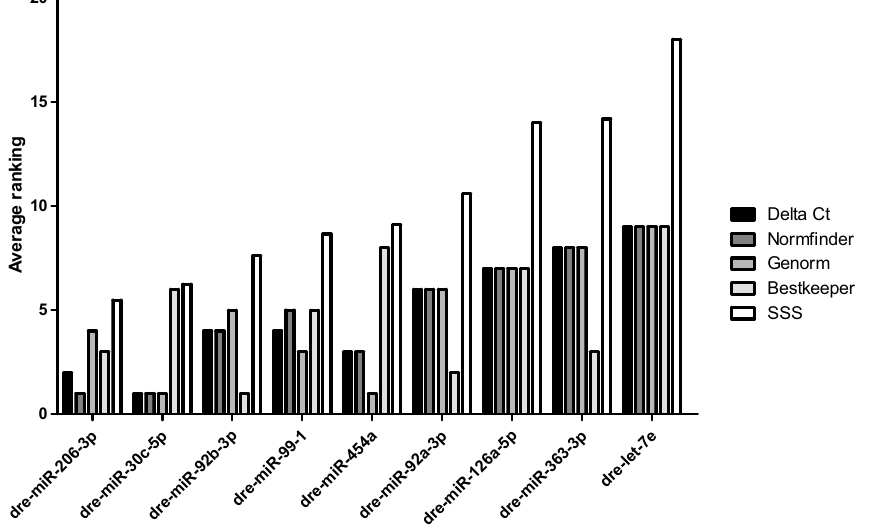
Figure 5. Average ranking of candidate miRs by 4 different normalization determination algorithms. Data was ranked by DeltaCt, Normfinder, Genorm and Bestkeeper. SSS = summarized stability